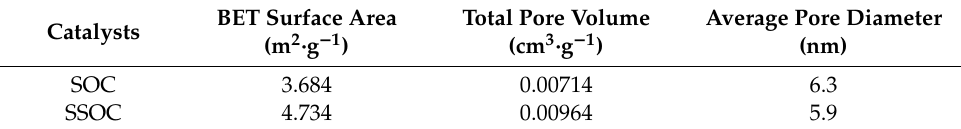
Table 2. Textural properties of the catalysts.